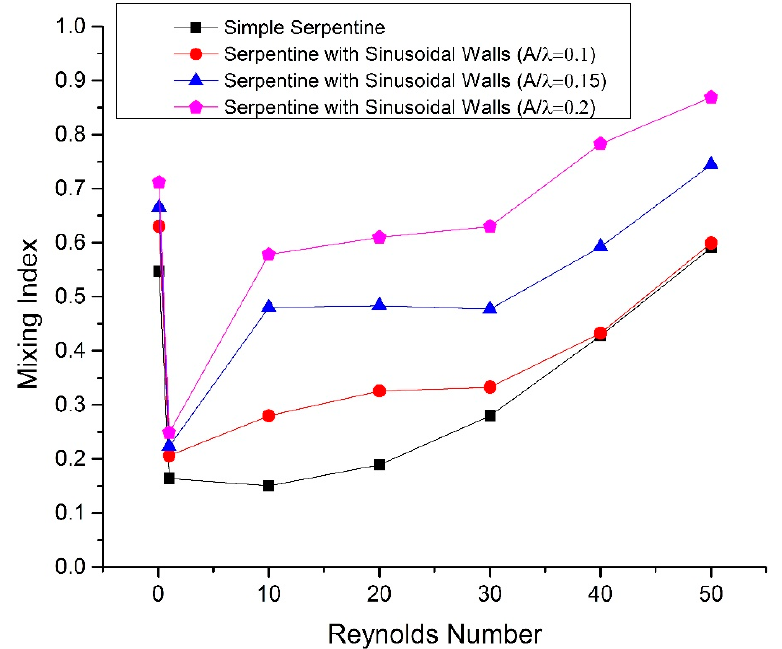
Figure 5. Mixing index vs Reynolds number at the exit.